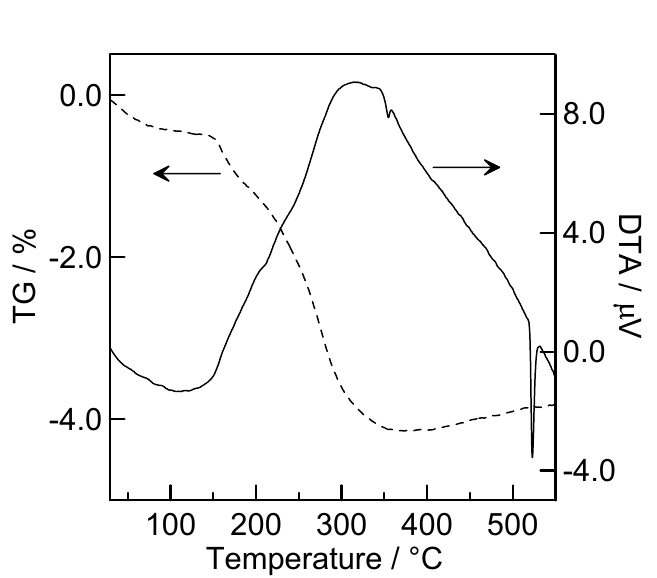
Figure 5. Results of differential thermal analysis (solid line) and thermogravimetry (dashed line) of a silver phosphate